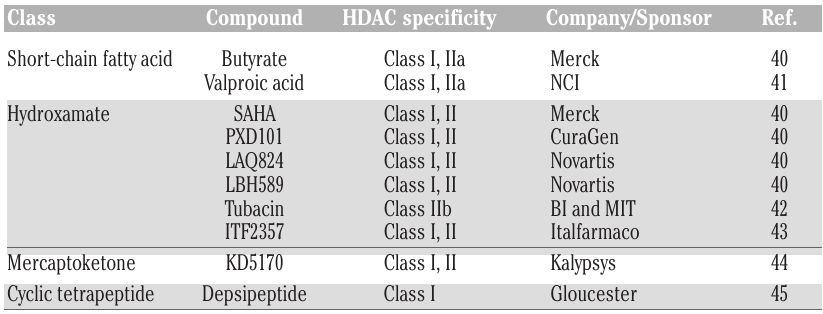
Table 1. Isoenzyme-selectivity of pan-HDACi.